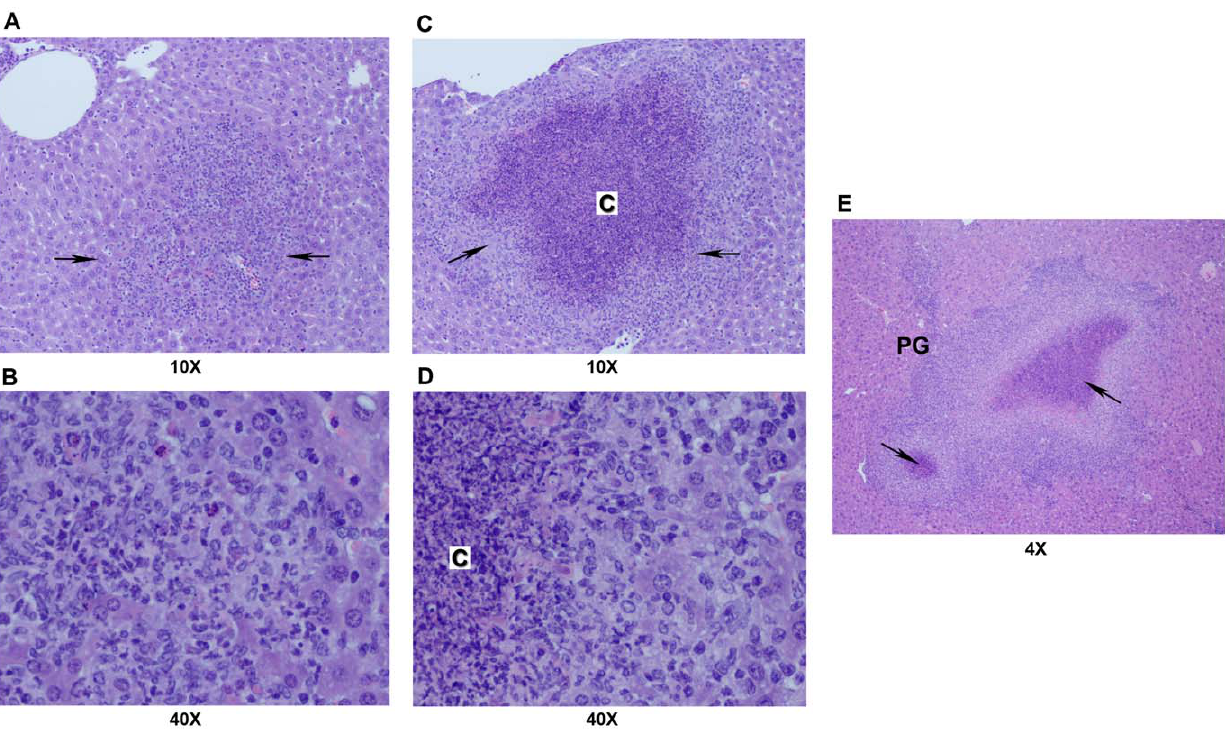
Figure 3. Pyogranulomatous inflammation of liver. Sections with varying degrees of severity of pyogranulomatous lesions: in (A) and (B), focal pyogranuloma (arrows) without caseous necrosis (shown at 10 and 40X magnification, respectively); in (C) and (D), a larger pyogranuloma (arrows) with a caseous necrotic center (designated as C; shown at 10 and 40X magnification, respectively); and in E, confluent pyogranulomas with caseous necrotic centers (arrows; shown at 4X magnification). Details of processing and staining of the tissue are described in Materials and Methods.